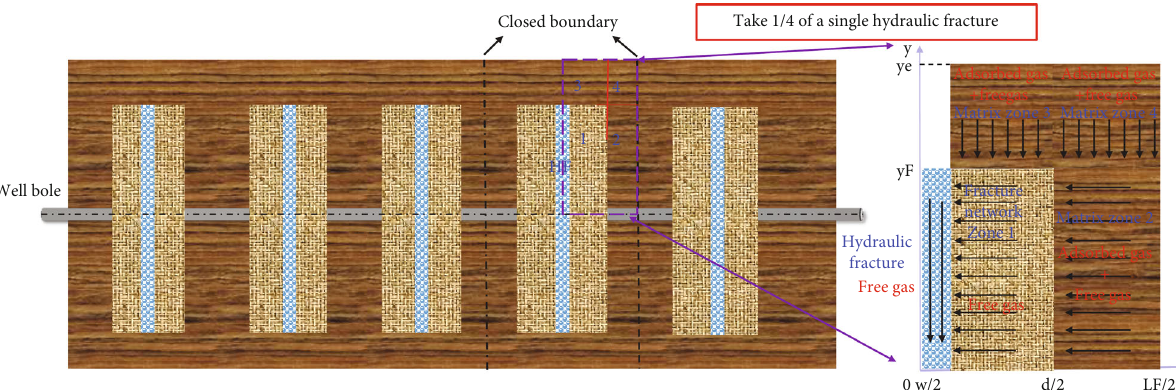
Figure 1: Simpli fi ed fi ve-zone composite physical model of a multifractured horizontal shale gas